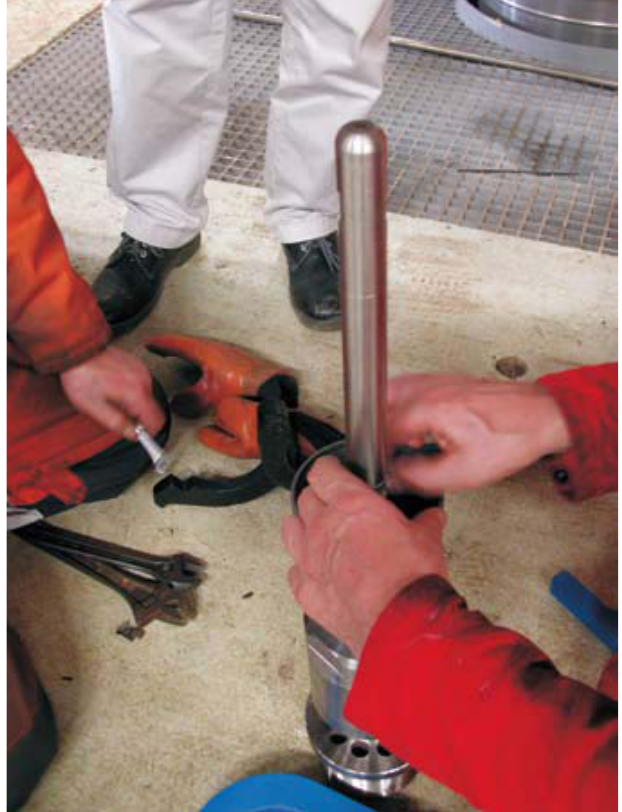
Figure 3. Temperature